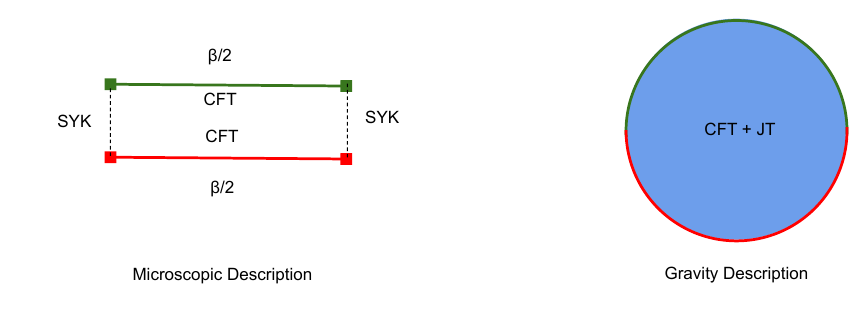
Figure 5. The microscopic (left panel) andgGravitational (right panel) description of the CFT density